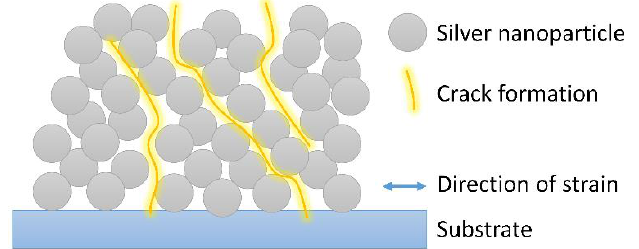
Figure 8. Schematic of the crack formation within the silver nanoparticle film. The schematic may be applied in the x - y plane and in the x - z -plane. All cracks lead to a lattice deformation that either preserves conductive paths or moves the lattice so that a conductive path is restored after relaxation.